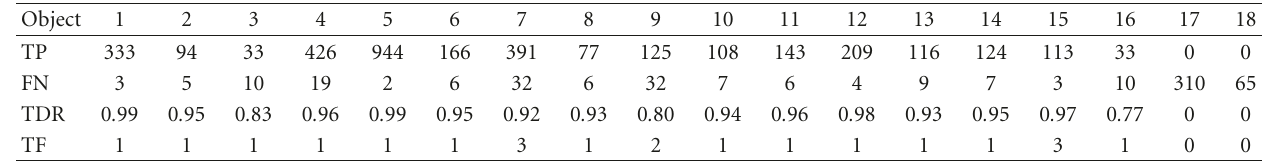
Table 2: Individual object performance results for the local feature tracking algorithm for S21-Cam7.